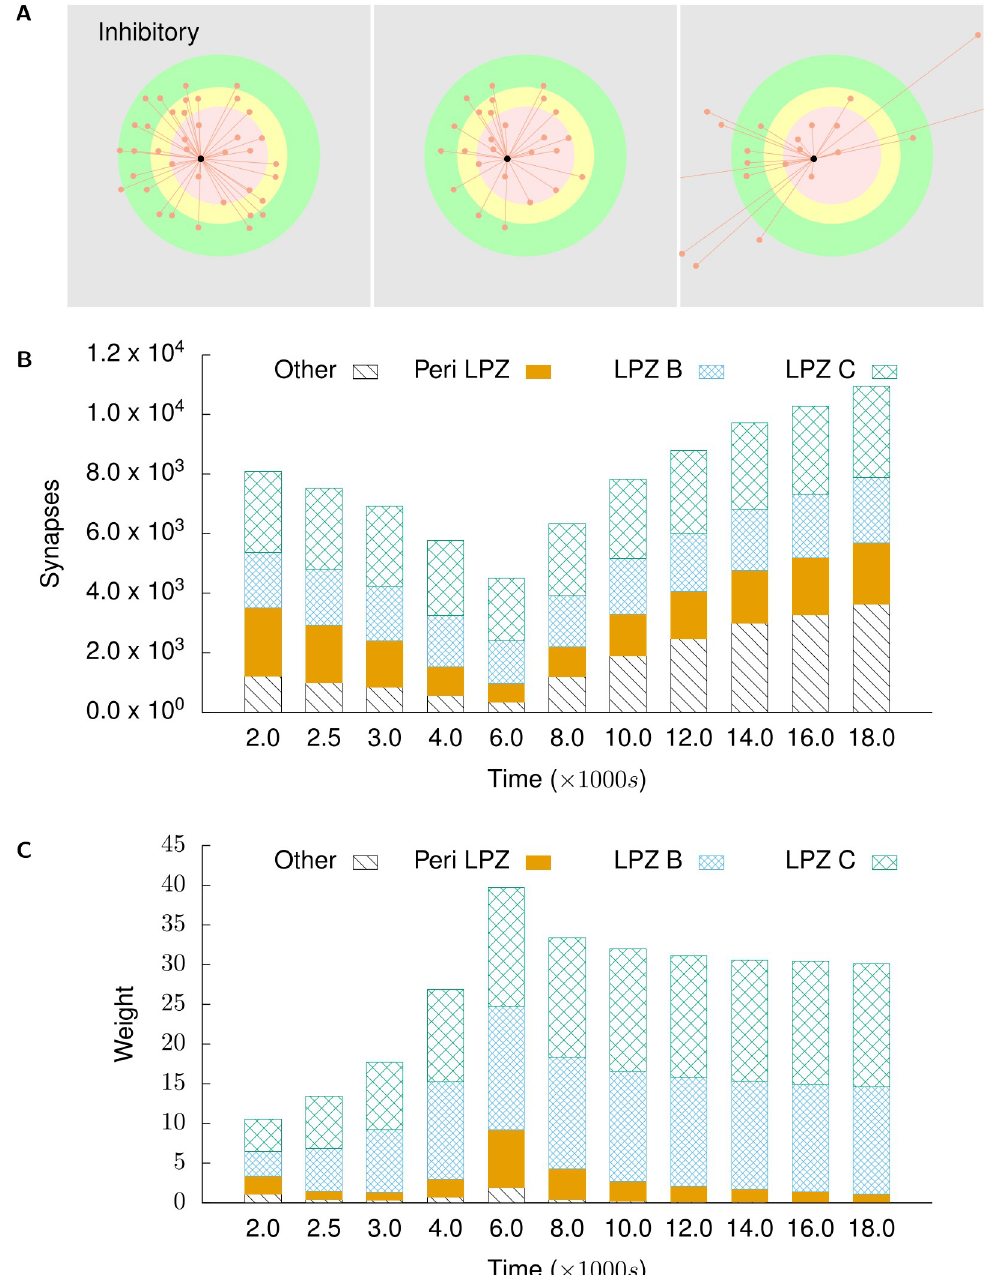
Fig 7. Inhibitory projections to excitatory neurons in the centre of the LPZ. (A) shows incoming inhibitory projections to a randomly chosen neuron in the centre of the LPZ at different stages of our simulations. From left to right: t = 2000 s, t = 4000 s, and t = 18,000 s. (B) shows the total numbers of incoming inhibitory projections to neurons in the centre of the LPZ from different regions at different points in time. (C) shows the mean weight of projections received by neurons in the centre of the LPZ from different regions at different points in time. Also in line with biological observations, they temporarily experience dis-inhibition after deafferentation. However, as these neurons gain activity from their new lateral excitatory inputs, the number of their inhibitory input connections increases again in order to restore the E-I balance.